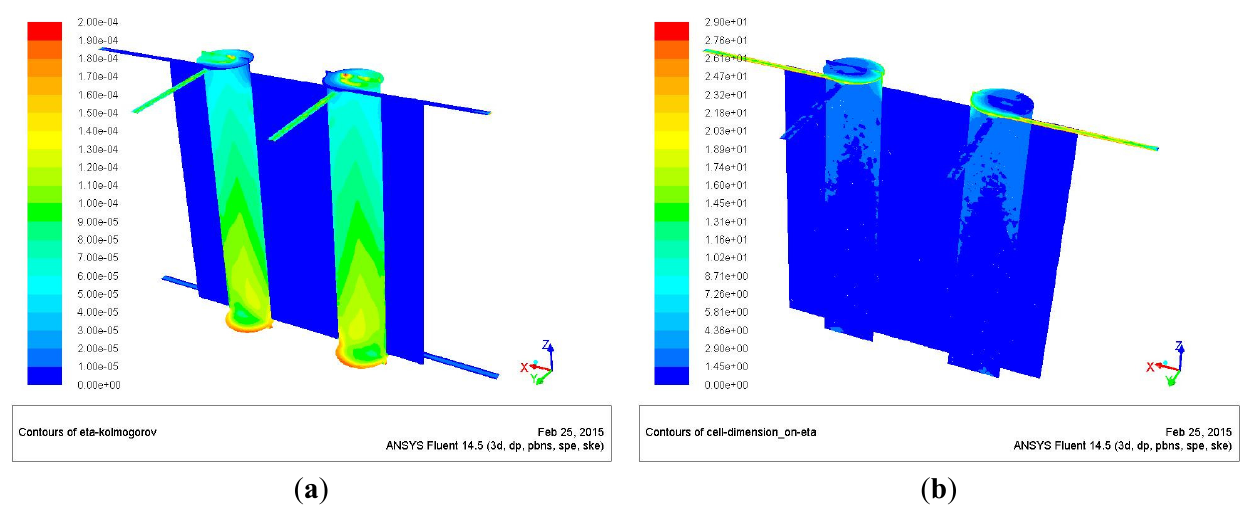
Figure 9. Kolmogorov scale dimension ( a ); cell dimension-Kolmogorov scale ratio ( b ).